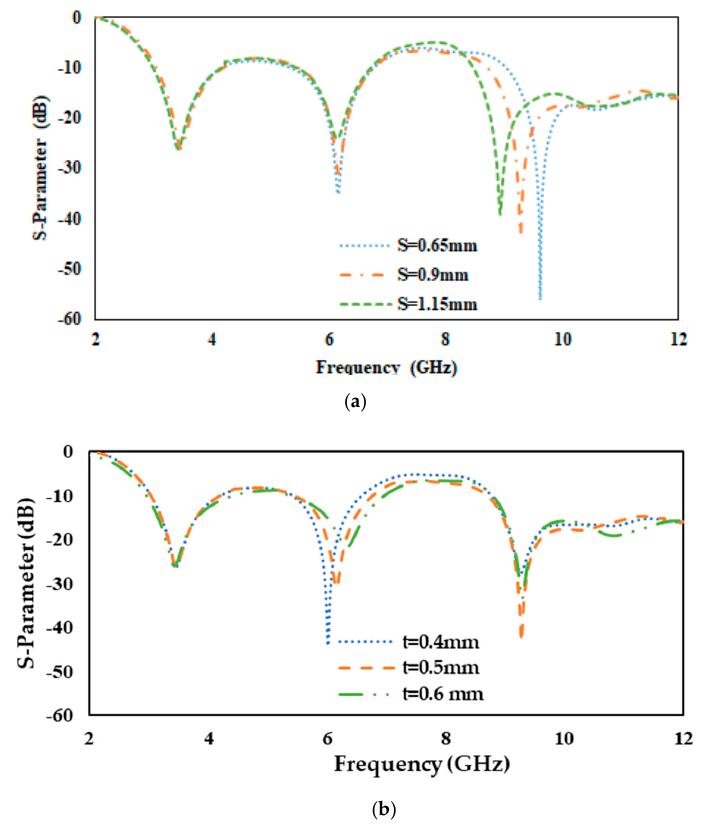
Figure 9. Simulated S-Parameter performance by varying ( a ) Triangular slot width ( S ) ( b ) SSRR slot width ( t ).